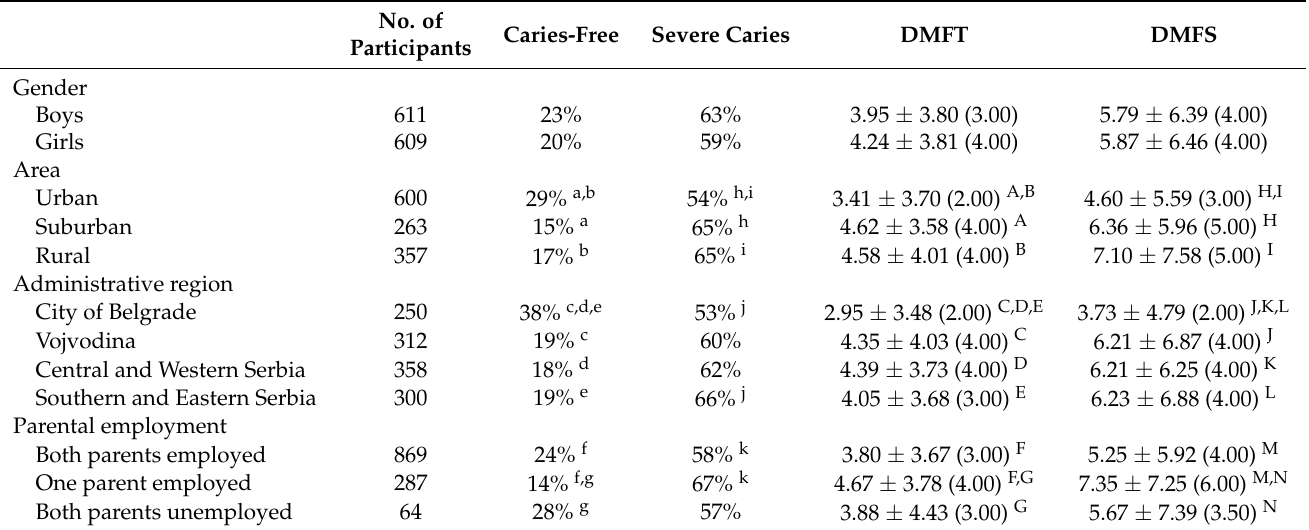
Table 4. Prevalence of caries-free and children with severe caries (%), DMFT and DMFS values (mean ± SD (median)) in 15-years old children in Serbia.